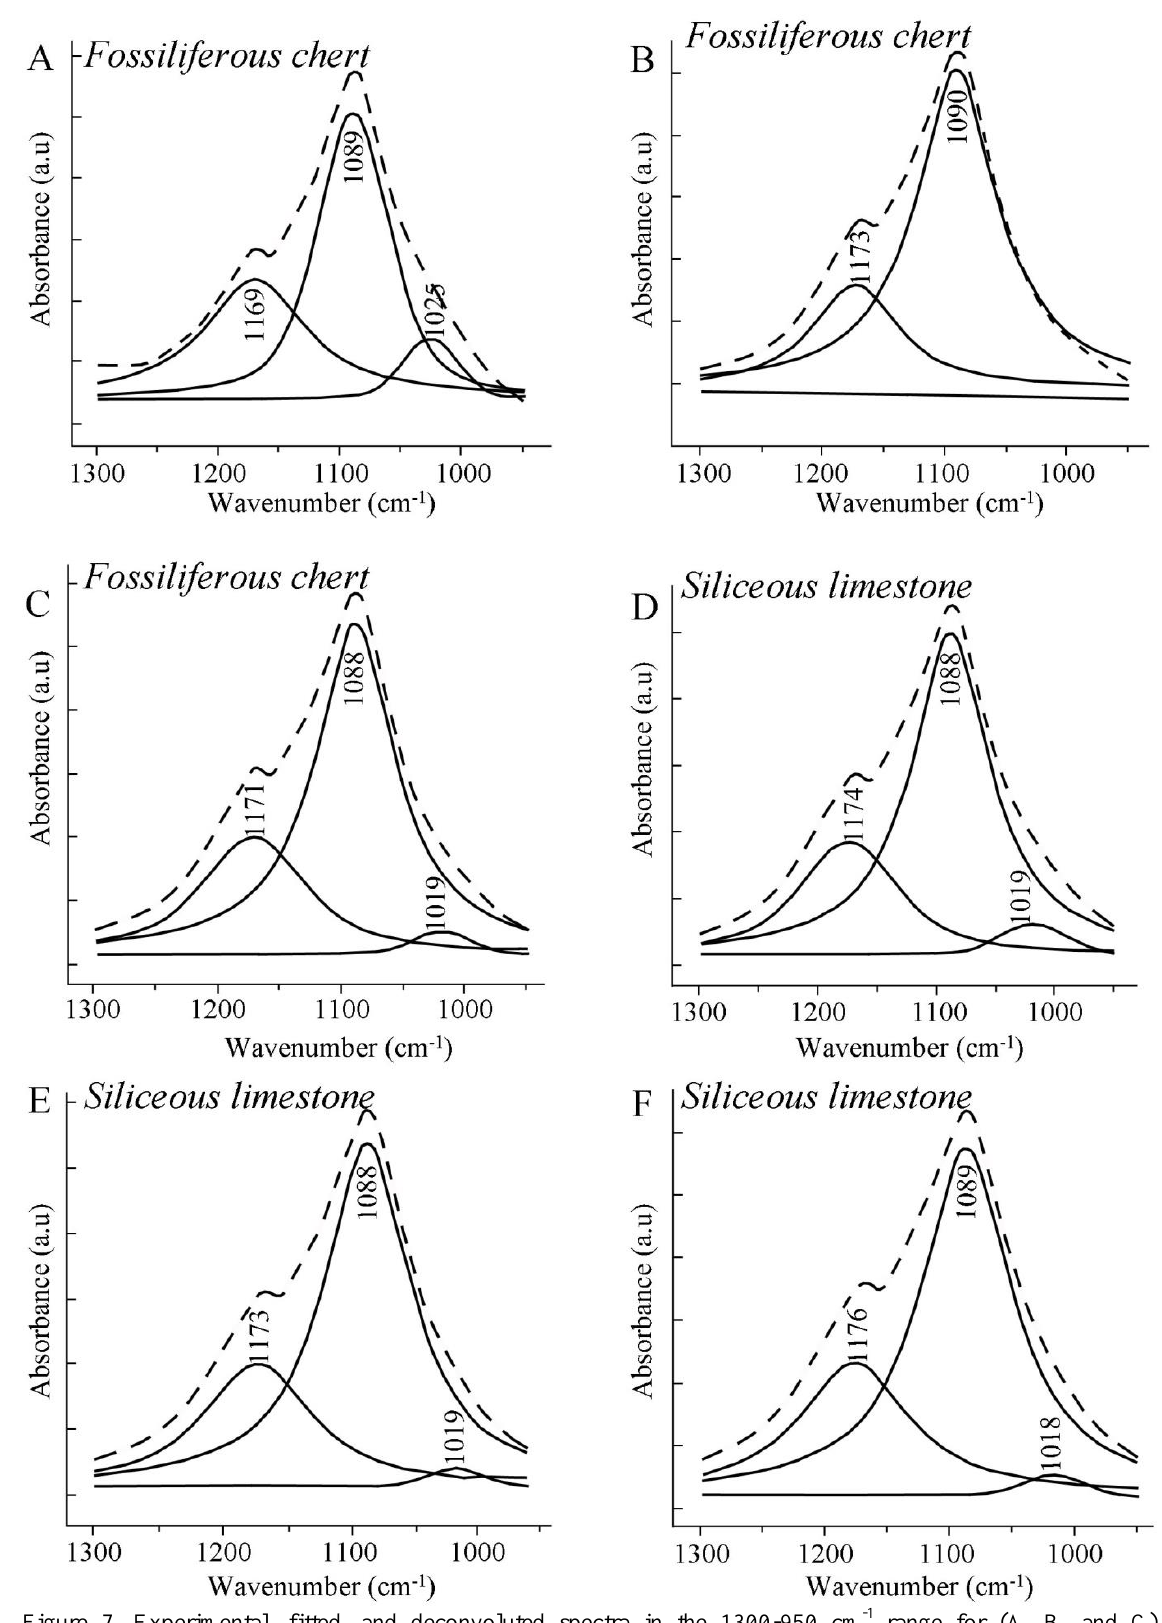
Figure 7. Experimental, fitted, and deconvoluted spectra in the 1300-950 cm -1 range for (A, B, and C) Fossiliferous chert: samples 4599, 4576(18), and 4469; (D, E and F) Siliceous limestone: samples 4542(2), 4446, and 4576(13). The experimental spectrum is drawn with a dashed